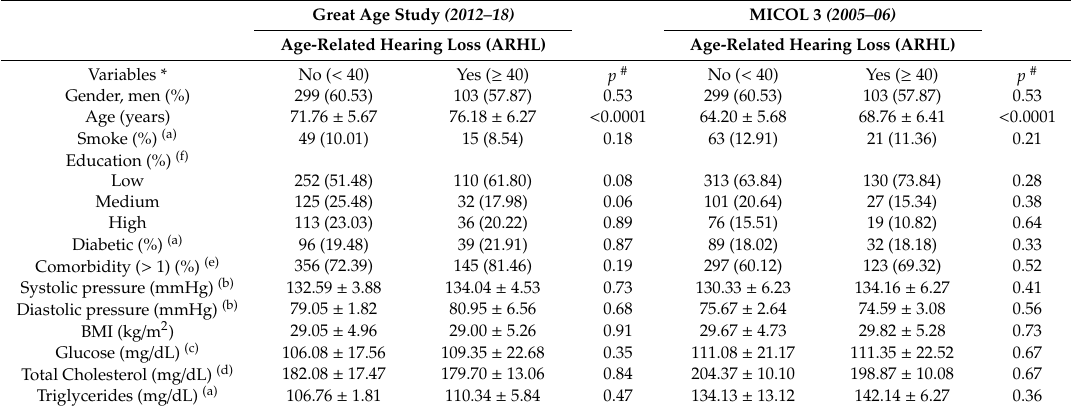
Table 1. Sociodemographic and clinical characteristics of the population at baseline (M3) and follow-up (GreatAGE Study, M4) ( n =